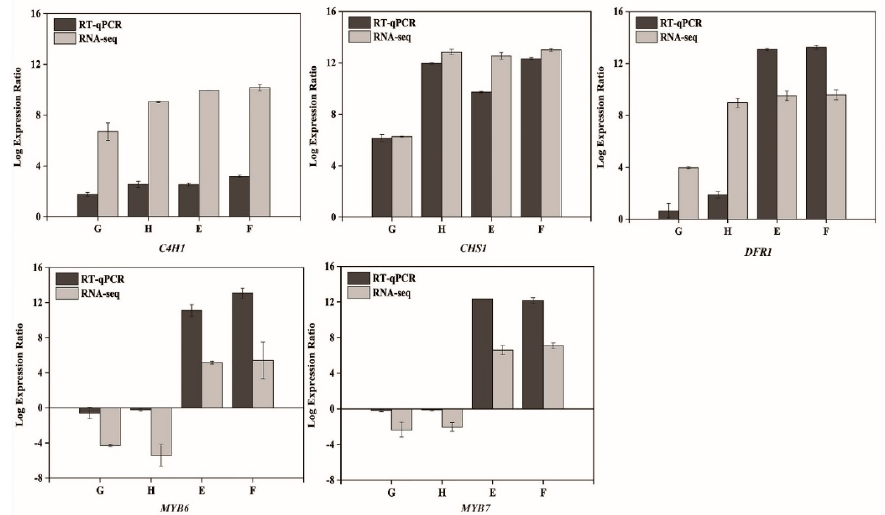
Figure 5. Validation of the RNA-seq results by qRT-PCR. Bars show means of Log2 FPKM data and Log2 qRT-PCR data of two and three biological replicates, respectively. FPKM means the expected number of fragments per kilobase of transcript sequence per Millions base pairs sequenced. E (xylem of ‘Purple 68 ′ ), F (phloem of ‘Purple 68 ′ ), G (xylem of ‘Purple Haze’) and H (phloem of ‘Purple Haze’).